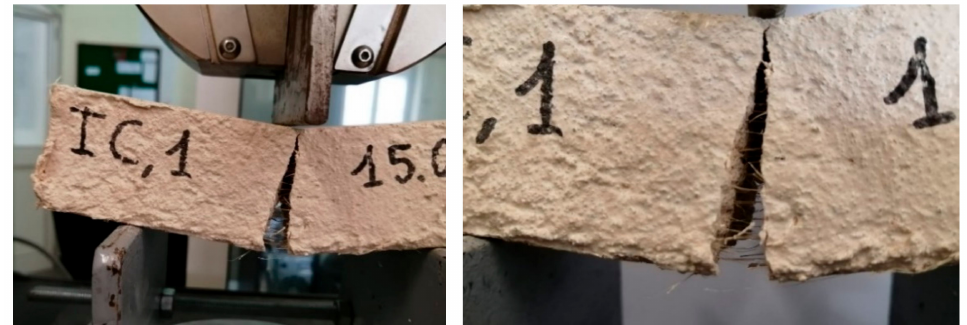
Figure 8. Sewing effect of fibers at the bending test.